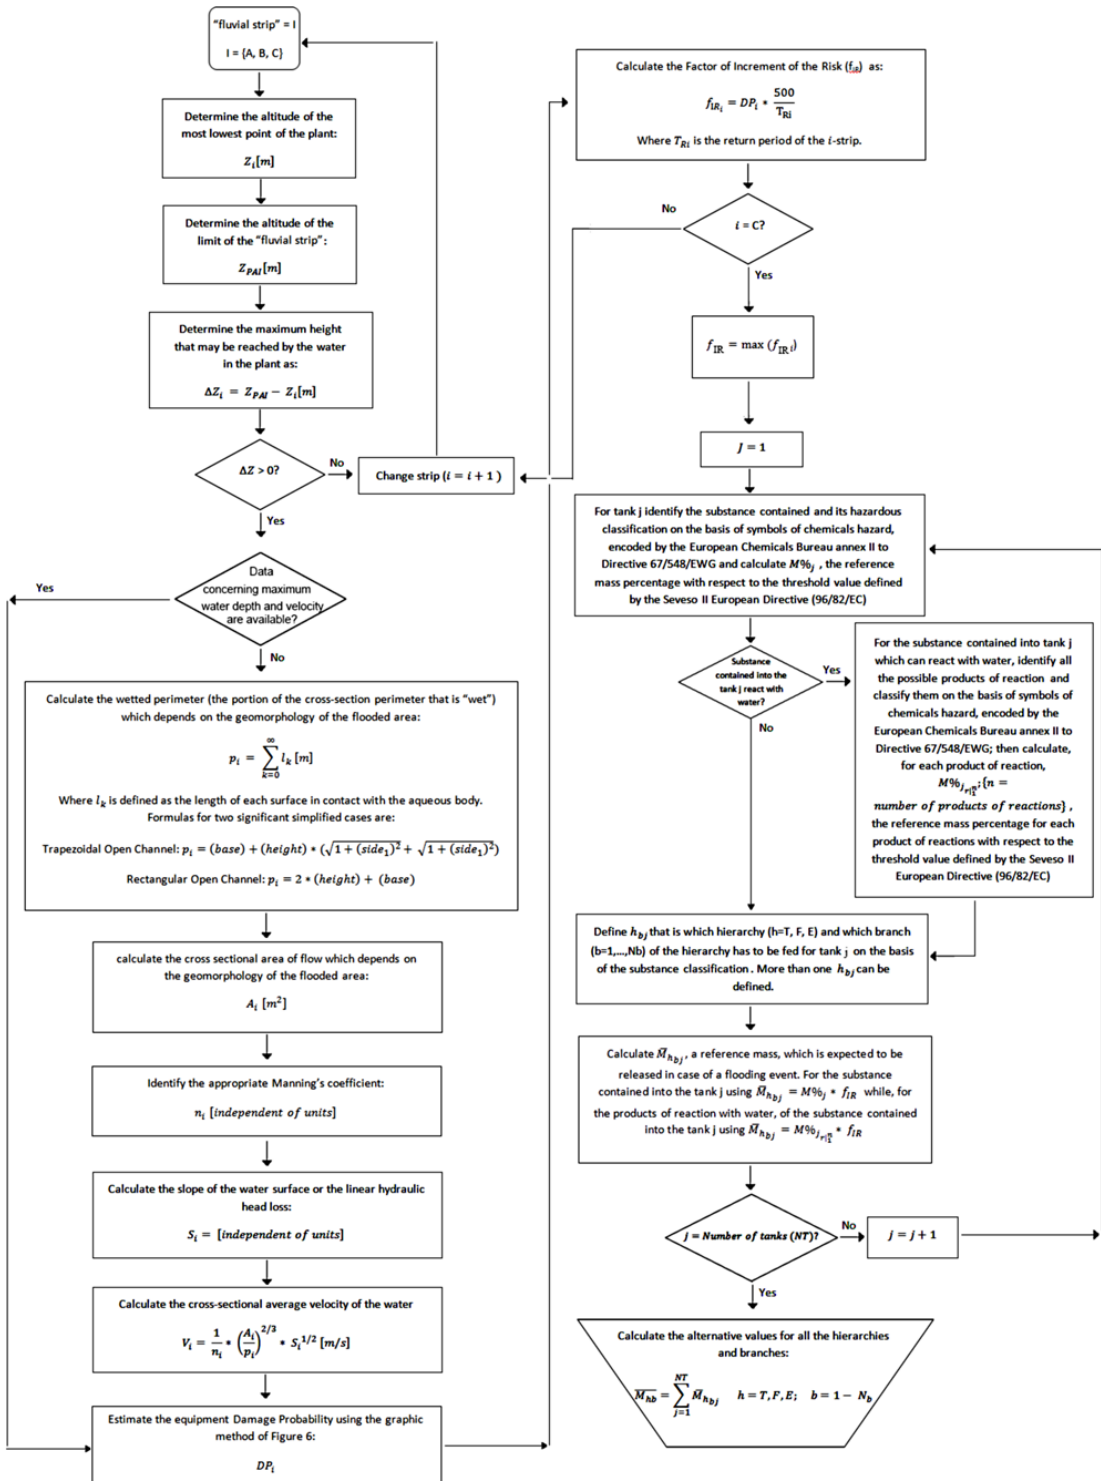
Fig. 4. Procedure for the evaluation of alternatives in the